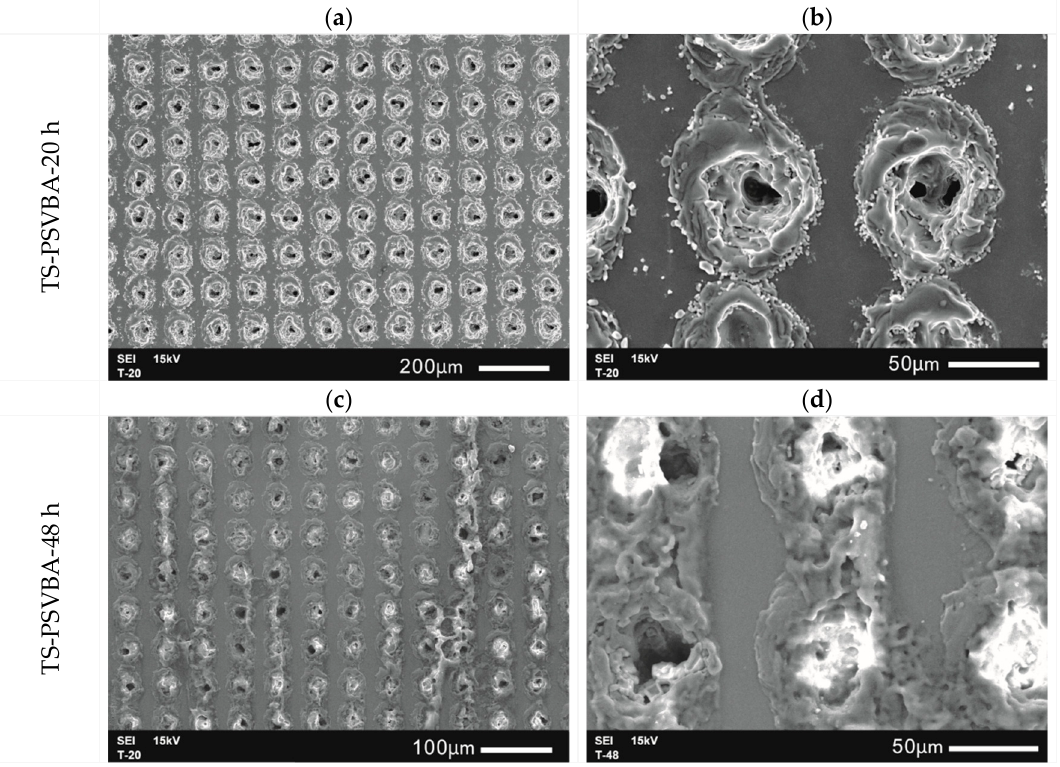
Figure 5. SEM morphologies of textured silicon surfaces grafted with PSVBA brushes: ( a , b ) 20-h grafted surface; ( c , d ) 48-h grafted